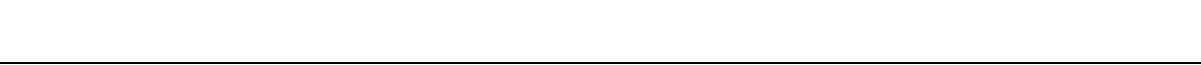
Figure 7.1 Figure